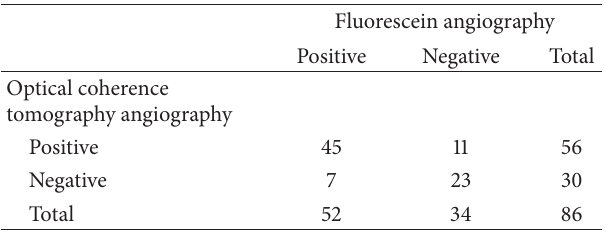
Table 1: Detection of eyes with neovascular age-related macular degeneration using optical coherence tomography angiography compared to fluorescein angiography.